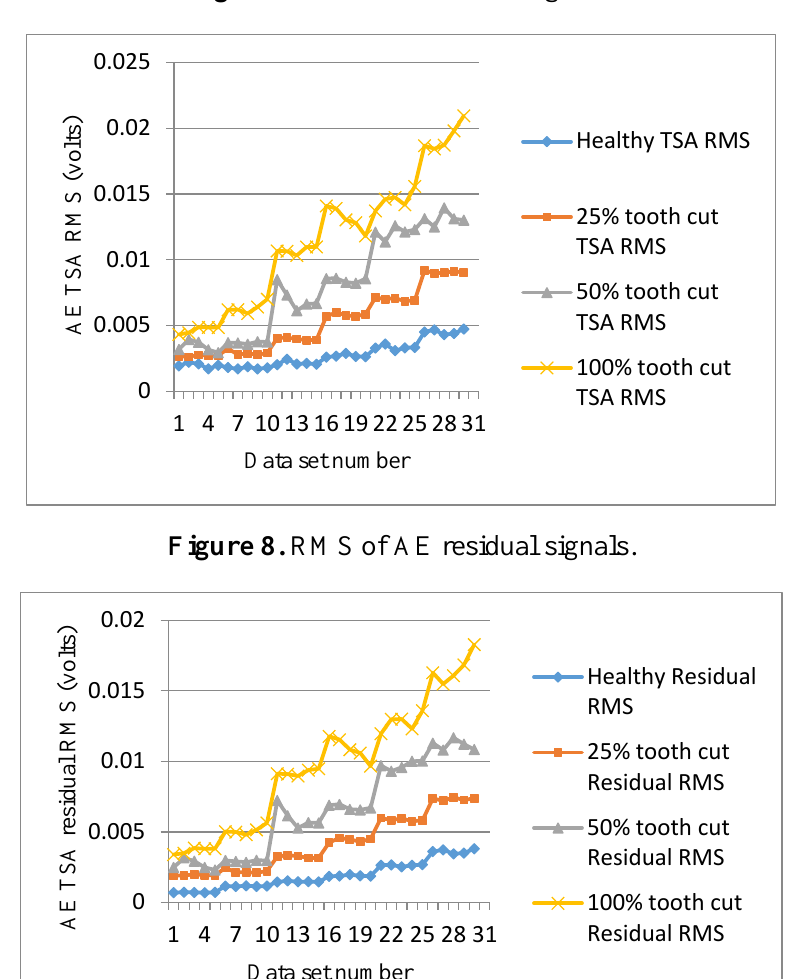
Figure 7. RMS of AE TSA signals.